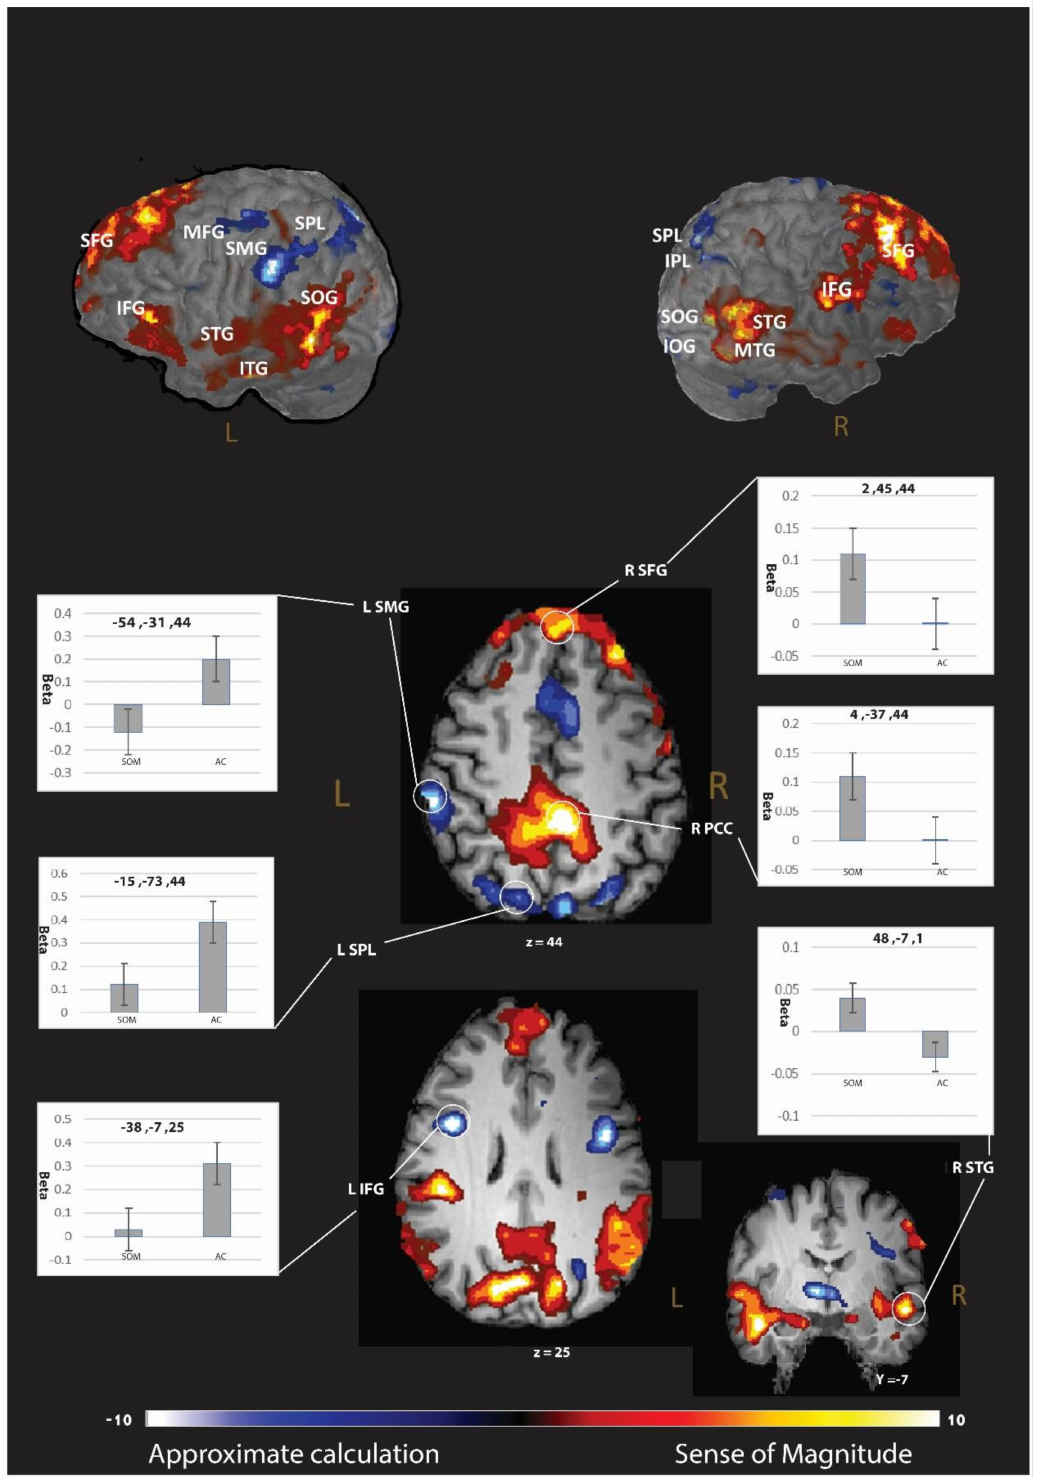
Figure 2. Brain regions associated with changes in neural activity in approximate calculation strategy related to sense of magnitude strategy. To unravel the brain regions that showed significant brain activation differences between the strategies, we calculated a whole-brain t -test between the brain activation of the two